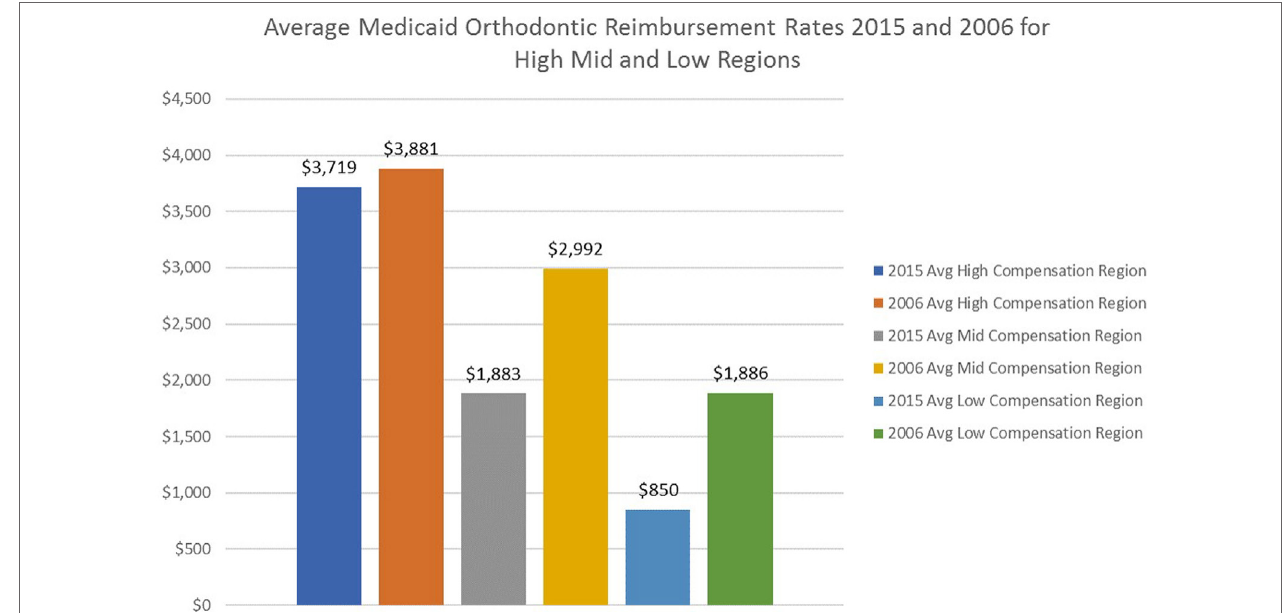
FigUre 4 | Comparison of Medicaid orthodontic reimbursement rates 2006 and 2015 for high, mid, and low